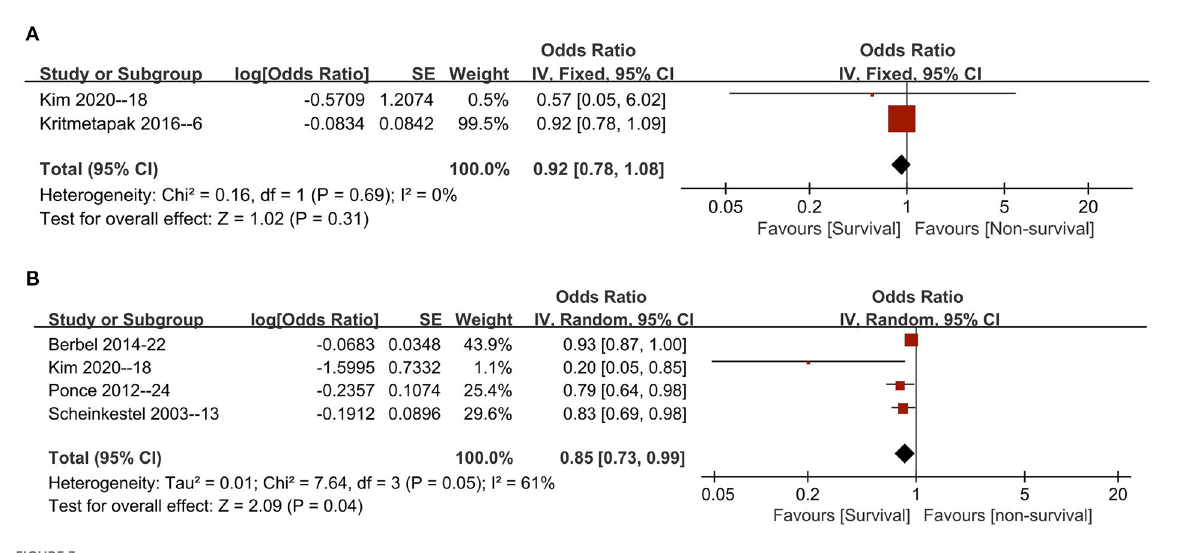
FIGURE3 The pooled estimate of OR of all-cause mortality with initial nitrogen balance (A) and final nitrogen balance (B) in critically ill patients. CI, confidence interval; IV, inverse variance; SD, standard